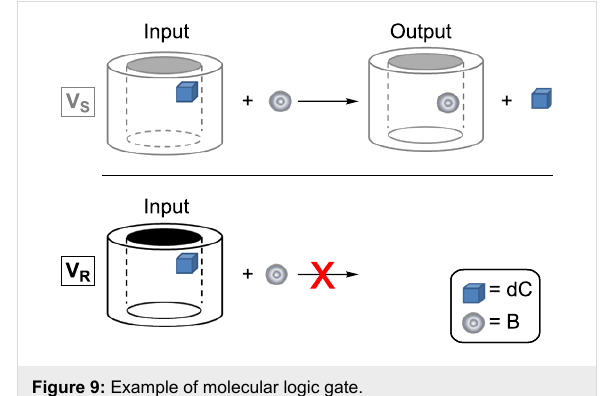
Figure 9: Example of molecular logic